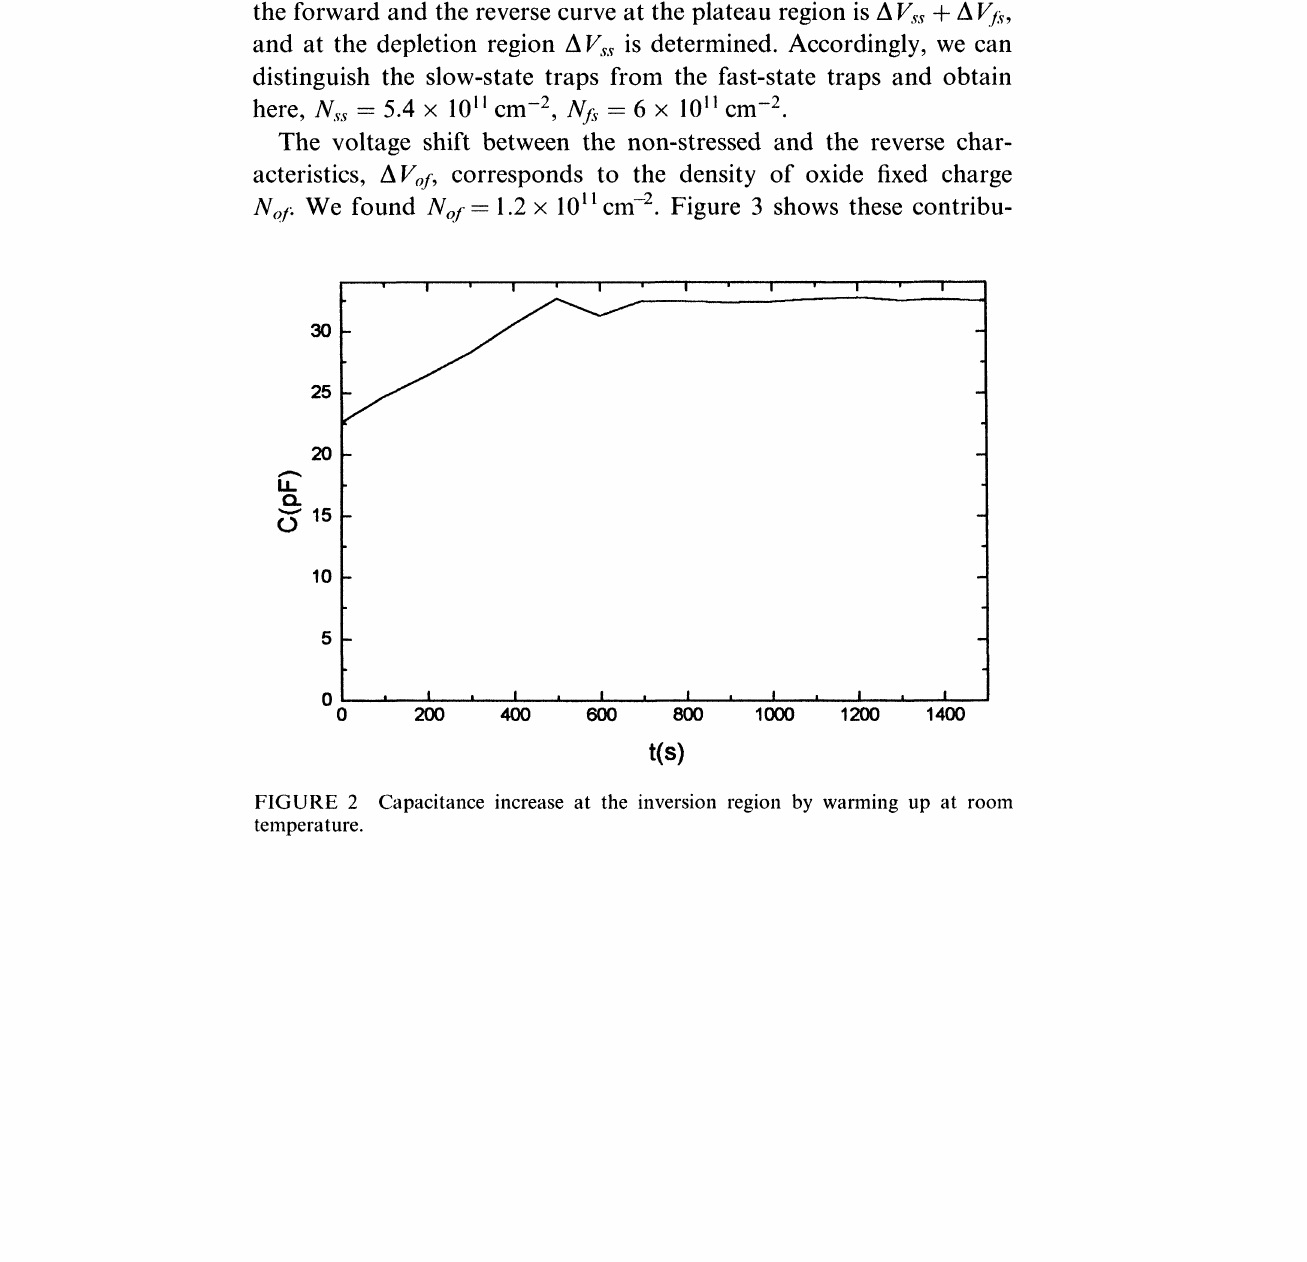
FIGURE 2 Capacitance increase at the inversion region by warming up at room